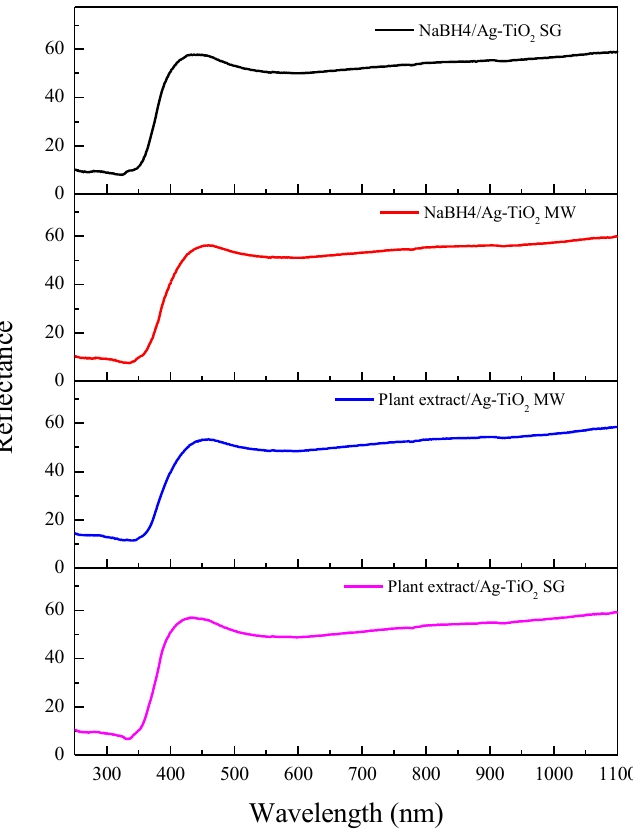
Figure 8. Ag-TiO 2 DRS spectra ( - ) NaBH 4 /Ag-TiO 2 SG, ( - ) NaBH 4 /Ag-TiO 2 MW, ( - ) plant extract/Ag- TiO 2 SG, ( - ) plant extract/Ag-TiO 2 MW.